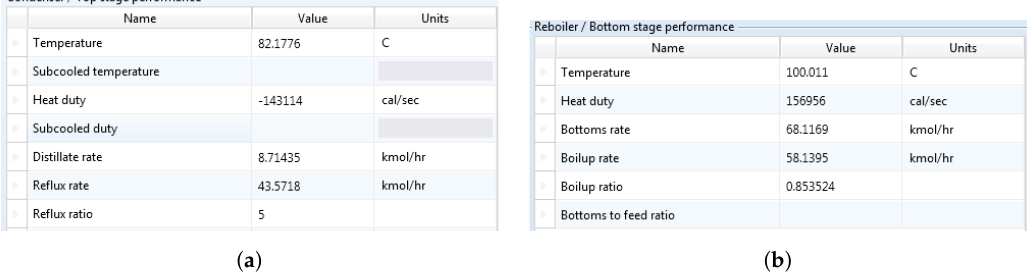
Figure 4. Aspen Plus ® screenshots of the performance of the top and bottom stages. ( a ) Top Stage Performance. ( b ) Bottom Stage Performance.